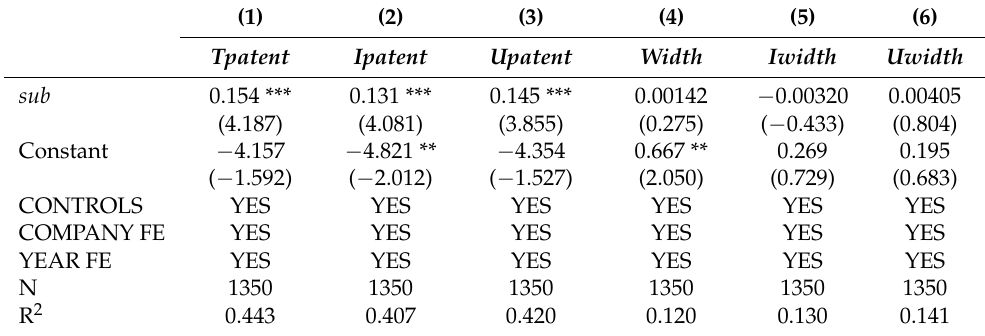
Table 7. Robustness test: Subsample.